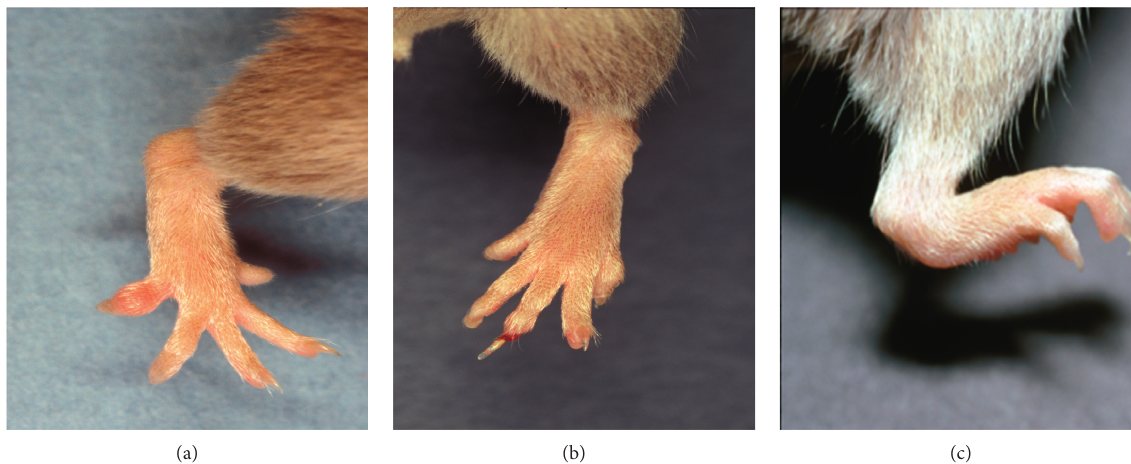
Figure 5: Oral Collagen-Induced Arthritis (oral CIA) and nonantibody mediated LPS-induced arthritis. Oral administration of heter- ologous type II collagen for a prolonged period can elicit very mild arthritis (oral CIA) in mice, (a) and (b), compared with typical severe arthritis in general CIA without LPS injection